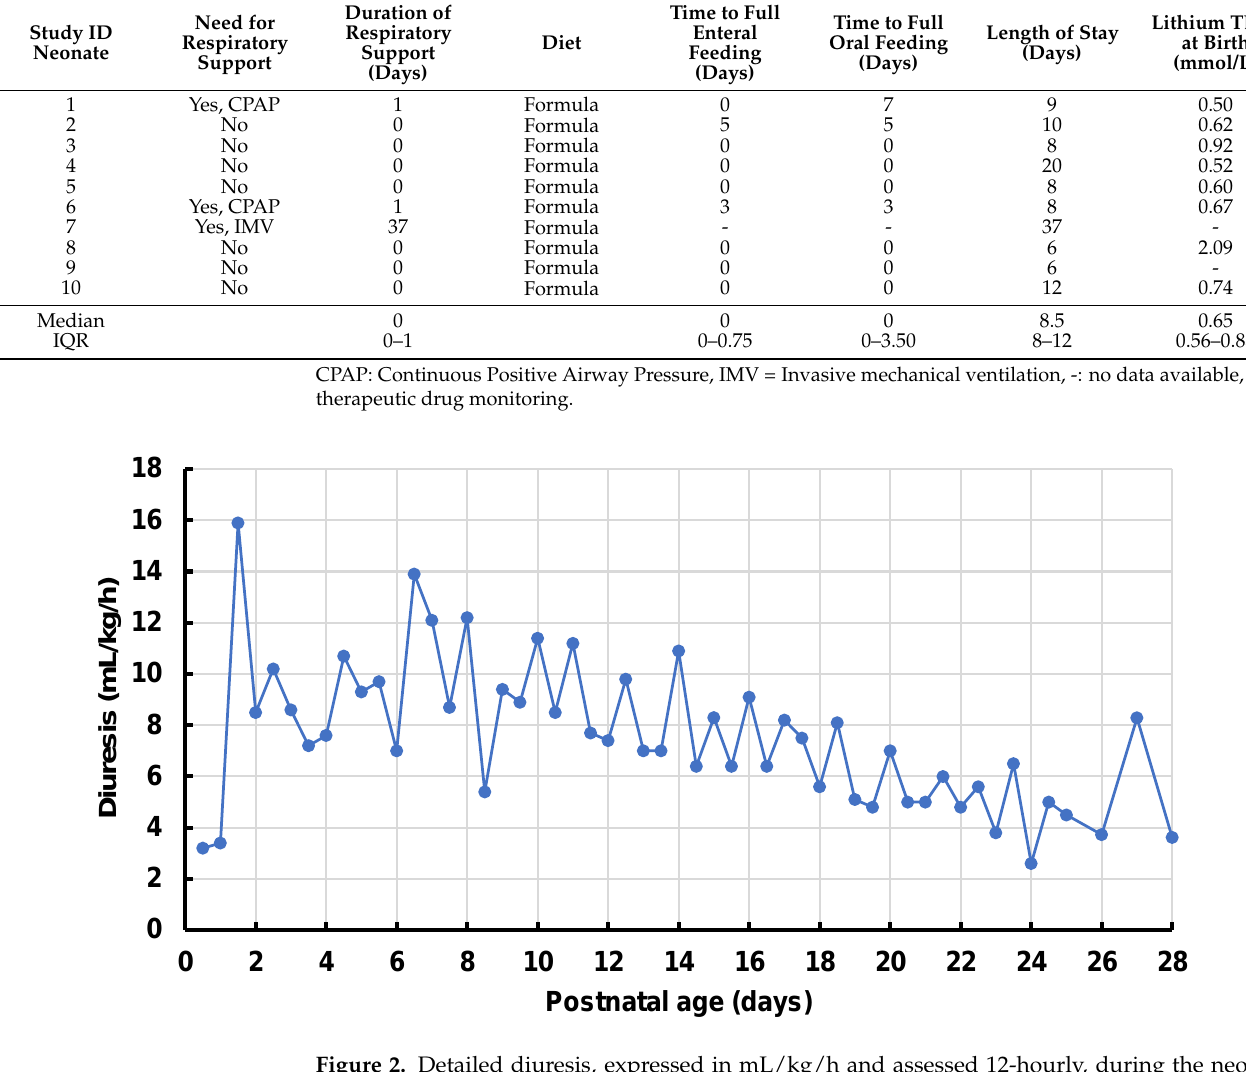
Figure 2. Detailed diuresis, expressed in mL/kg/h and assessed 12-hourly, during the neonatal period (i.e., first 28 days of life), of 1 neonate of the study cohort presenting with nephrogenic diabetes insipidus. Details on this case can be found in the text. Table 2. Characteristics of the included neonates at birth .